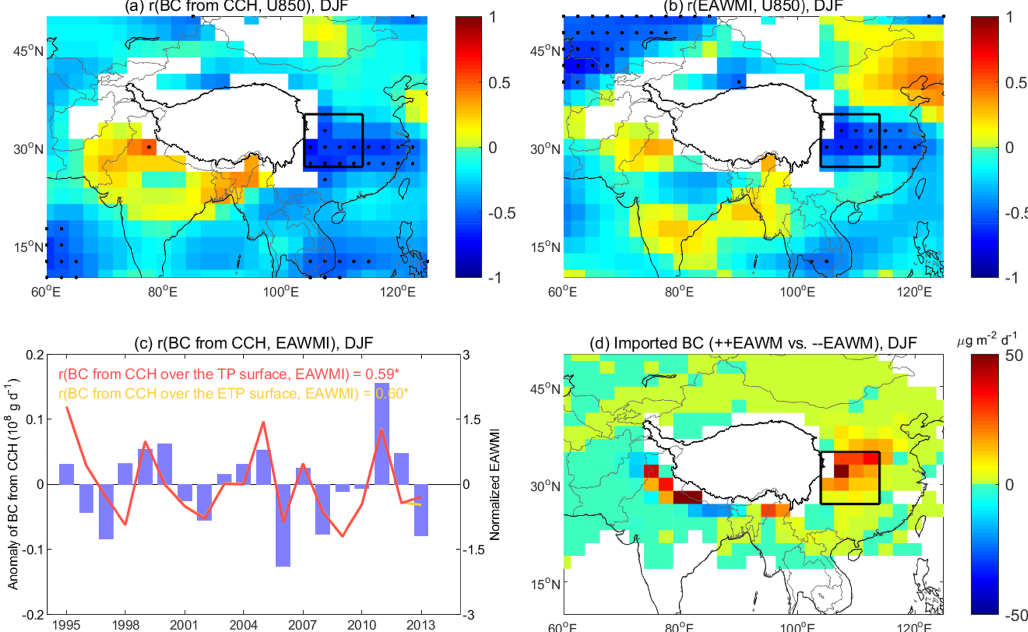
Figure 11. Connection between BC transport from East Asia to the TP surface and the EAWM in winter. (a) Correlation coefficients ( r ) between imported BC from central China (CCH) to surface BC in the TP and zonal wind at 850hPa (U850); (b) r between the EAWMI and U850; (c) inter-annual variations in the intensity of the EAWM and imported BC from CCH to the surface of the TP and eastern TP (ETP); (d) differences in BC transport to the TP surface between the years with strong and weak EAWM. Dots in (a) and (b) indicate that the r in the corresponding grid is statistically significant ( p < 0 . 05). The unfilled grids in (a) and (b) are due to the topography. An r with “*” in (c) indicates that the r is statistically significant ( p < 0.05). Boxed areas in (a) , (b) , and (d) indicate CCH (see Fig. 4d). The dark black line in (a) , (b) , and (d) encloses the domain of the